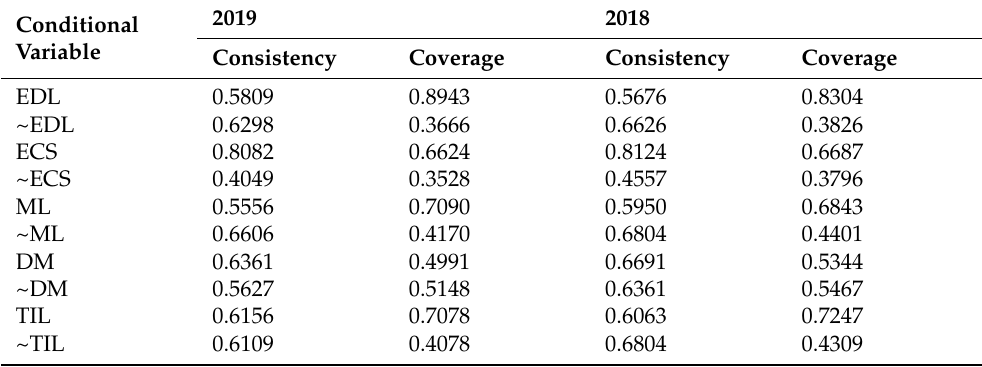
Table 6. Necessary condition